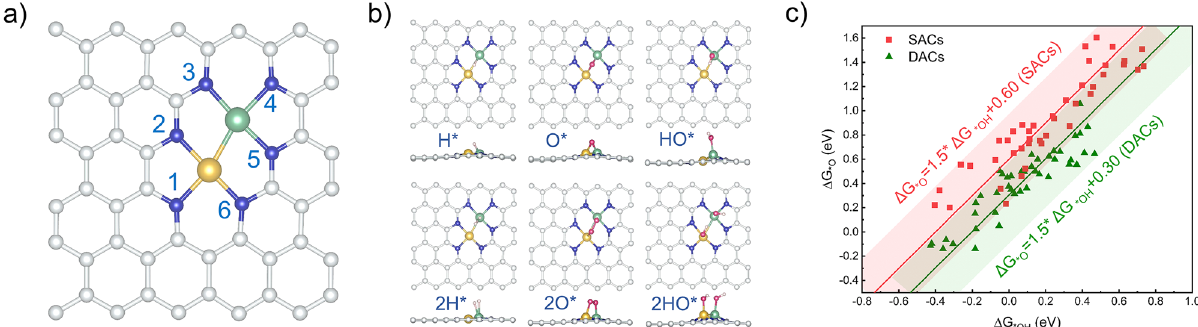
Fig. 2 Structures and adsorption properties of DACs. a Structure and coordinating environment of Fe-Ni-N 1,2,3,4,5,6 -C, where yellow, green, blue, and silvery spheres represent Ni, Fe, N, and C, respectively. b Optimized con fi gurations with the DAC adsorbed with 1H*, 2H*, 1O*, 2O*, 1HO*, and 2HO*, using Fe-Ni-N 1,2,3,4,5,6 -C as the example. Red and light pink spheres represent O and H, respectively. c Linear scaling relations of O ∗ vs. HO* adsorption energies at SACs and DACs, where red and green data points represent SACs and